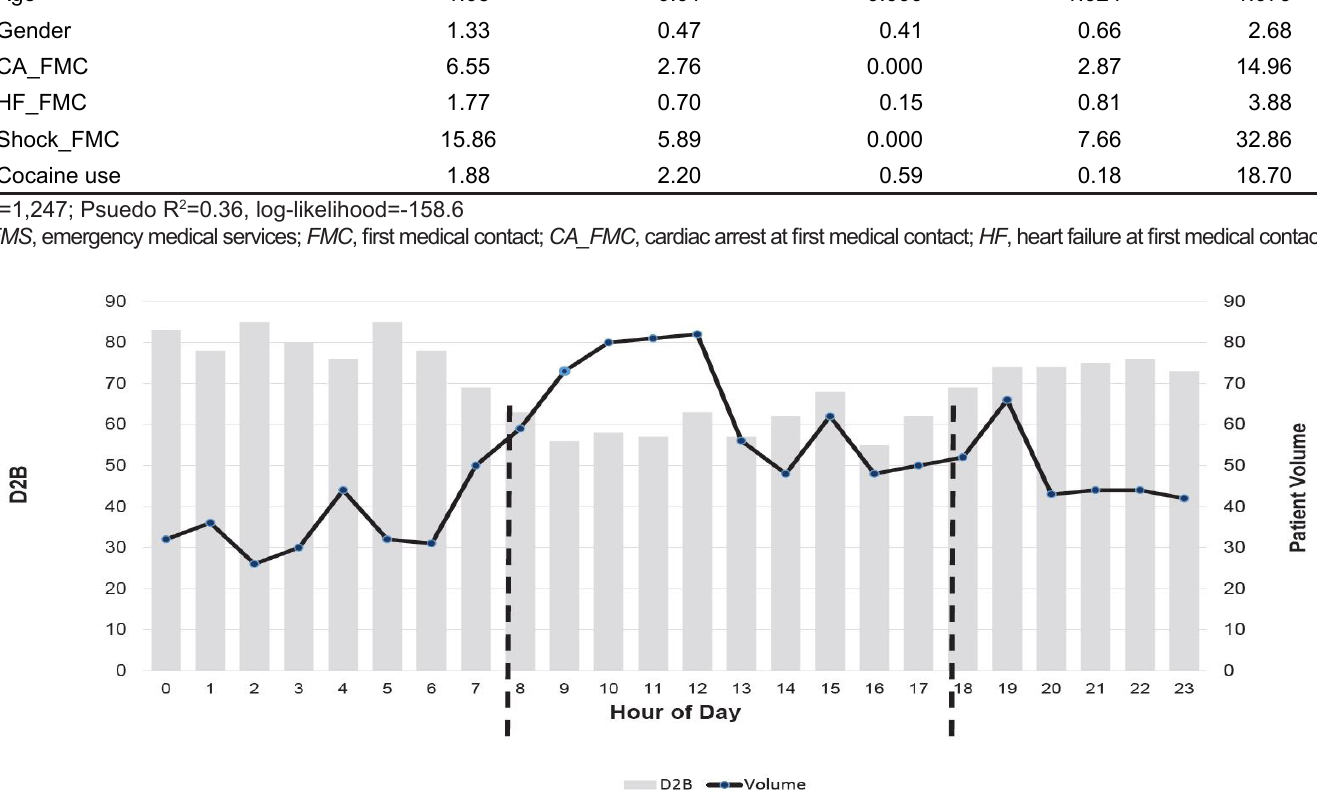
Figure 2. Distribution of STEMI patients by time of day. STEMI, ST-elevation myocardial infarction; D2B ,